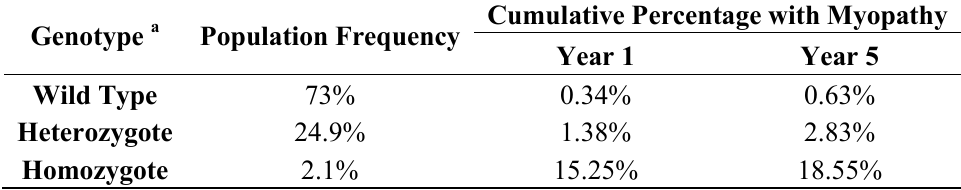
Table 6. Myopathy Risk in SEARCH Stratified by SLCO1B1 Genotype